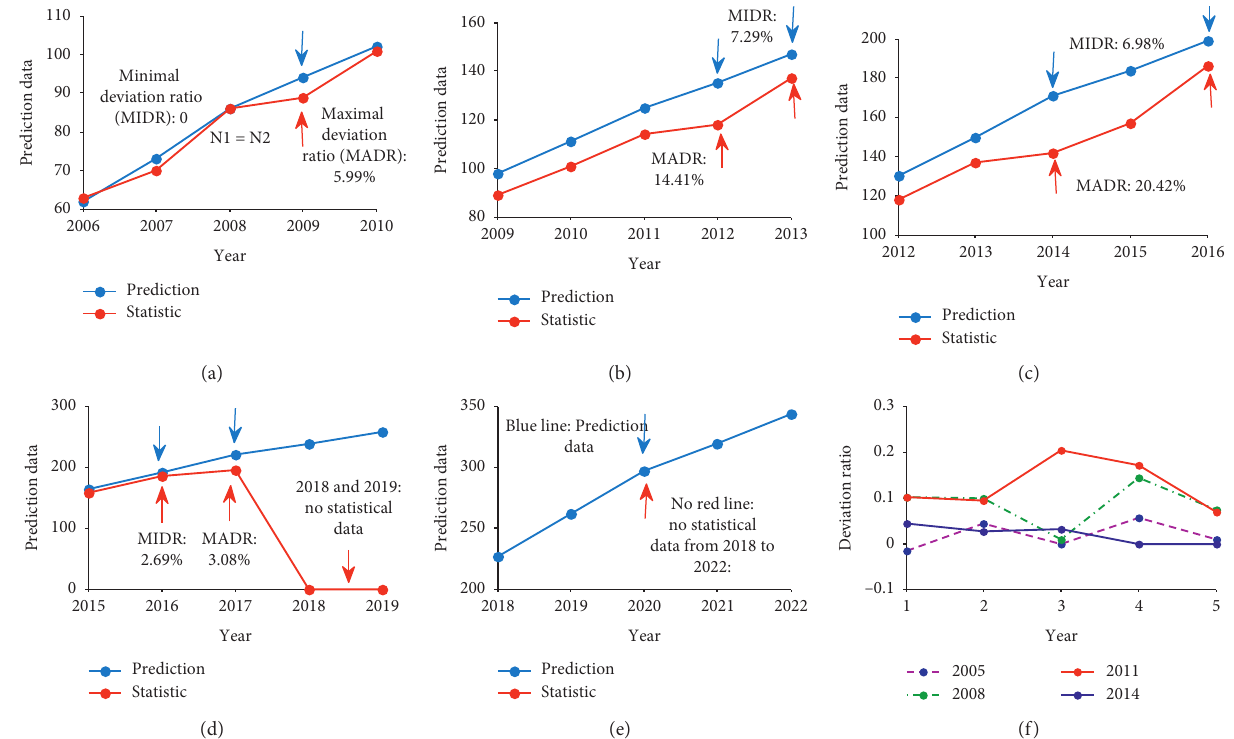
Figure 6: Prediction data changes and statistical data changes based on different initial years taken as input data. There is a significant and rough difference in the average per-year prediction data and statistical data between the size-rise and the size-decline phases across the 5 years analysed. Each pair of values corresponds to the predicted or statistic result of the same year. (a) Taking 2005 as an input, a PDP system is used to predict five-year population size from 2006 to 2010, respectively; (b) taking 2008 as an input, prediction years from 2009 to